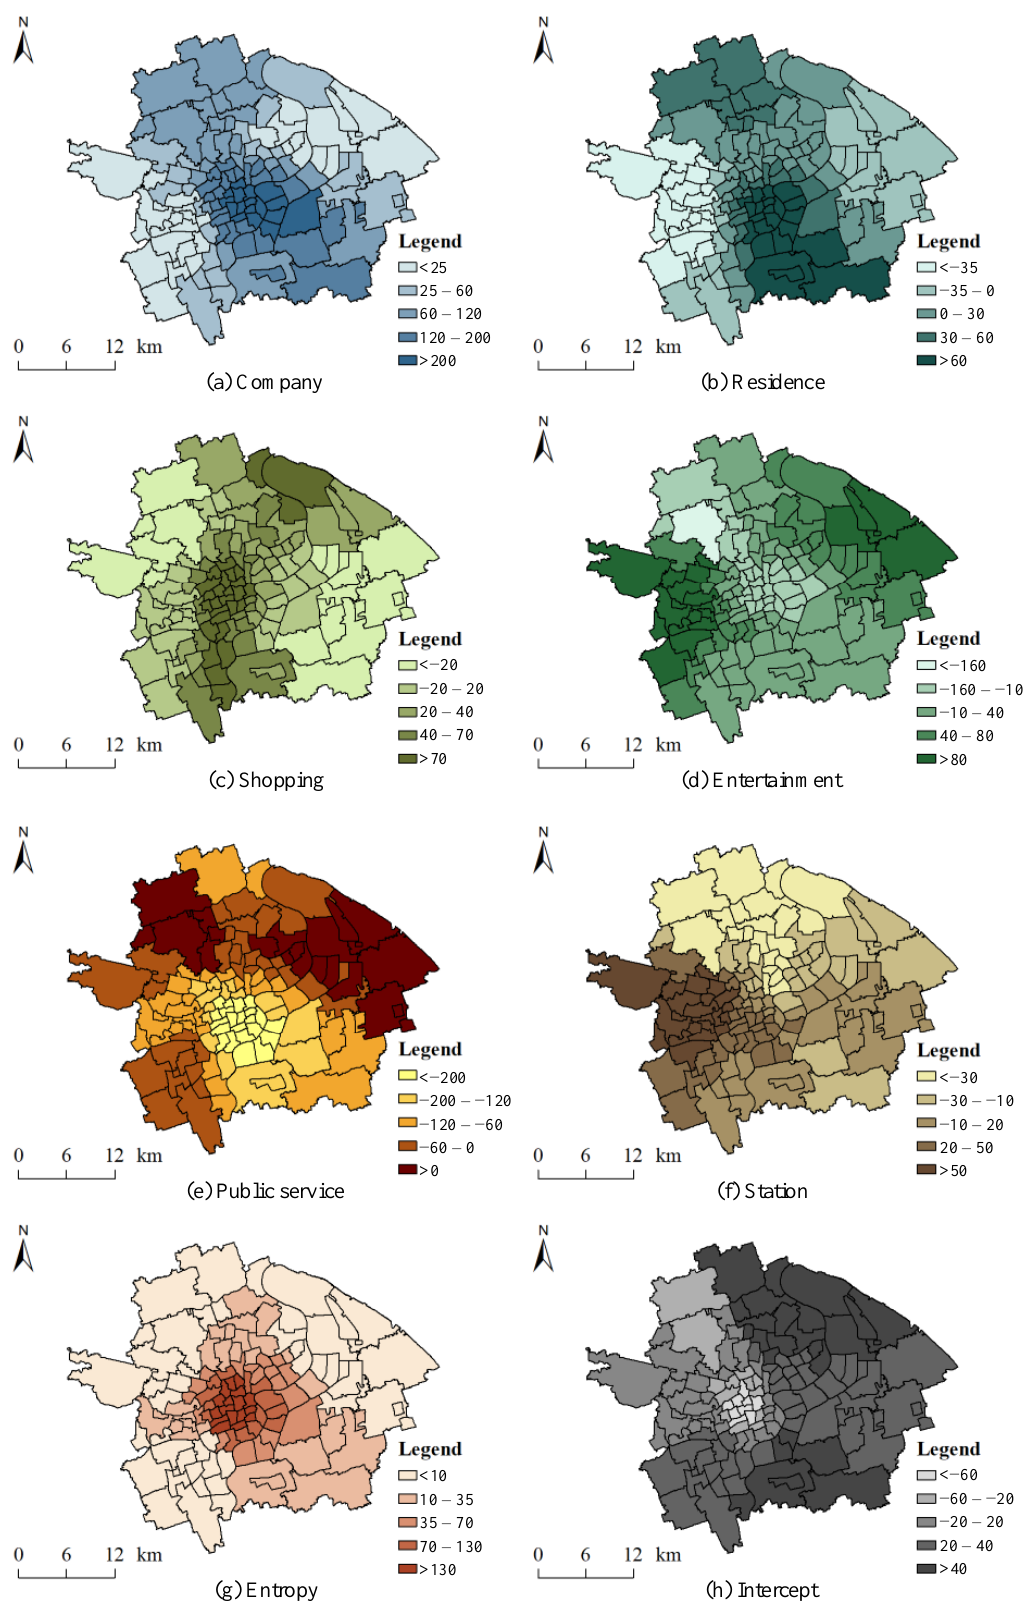
Figure 6. Coefficient distribution of the geographical weighted regression results: ( a ) Company; ( b ) Residence; ( c ) Shopping; ( d ) Entertainment; ( e ) Public service; ( f ) Bus station; ( g ) POI entropy; ( h ) Intercept.